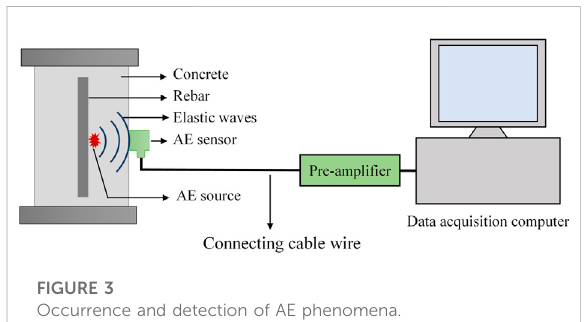
FIGURE 3 Occurrence and detection of AE phenomena.